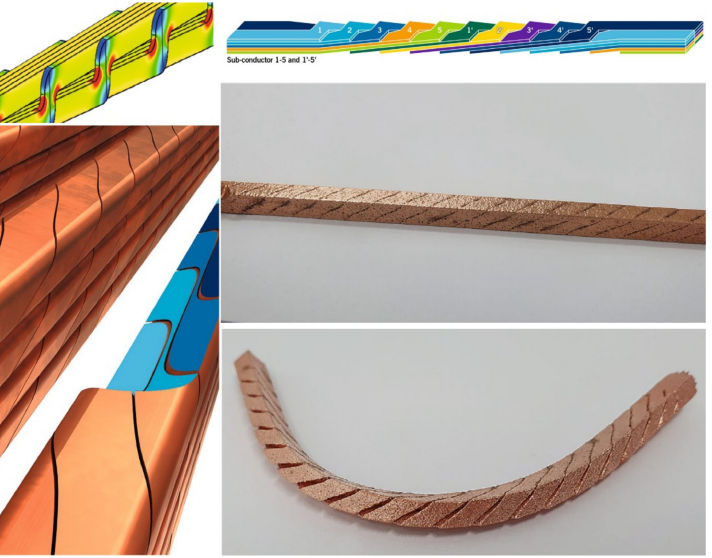
Figure 18. AM Roebel bar copper conductors with rectangular cross section insulated strands (straight and bended shapes) [71].